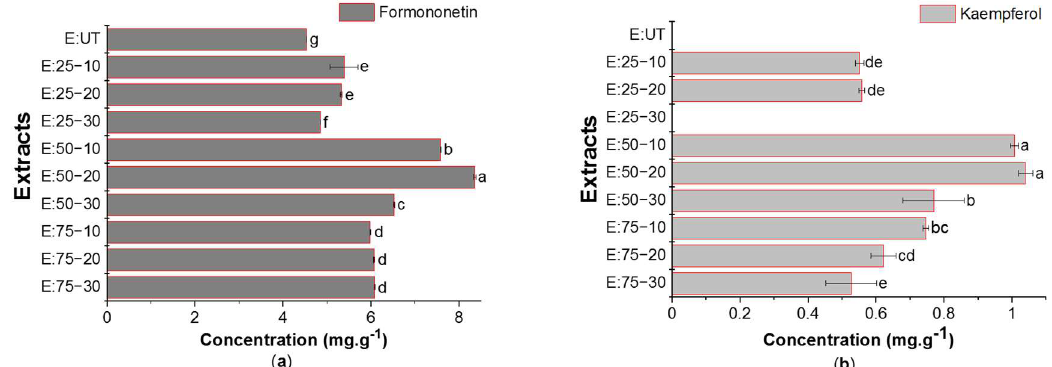
Figure 3. Quantification of ( a ) formononetin and ( b ) kaempferol contents with chromatographic method (HPLC) in the red propolis extracts obtained under different conditions. Values presenting the same letter in the same analysis do not show significant differences ( p > 0.05) in Tukey’s test at 95% confidence. Samples E:UT and E:25−30 presented values lower than the quantification limit for kaempferol. Average of analyses obtained from triplicates ( n = 3).